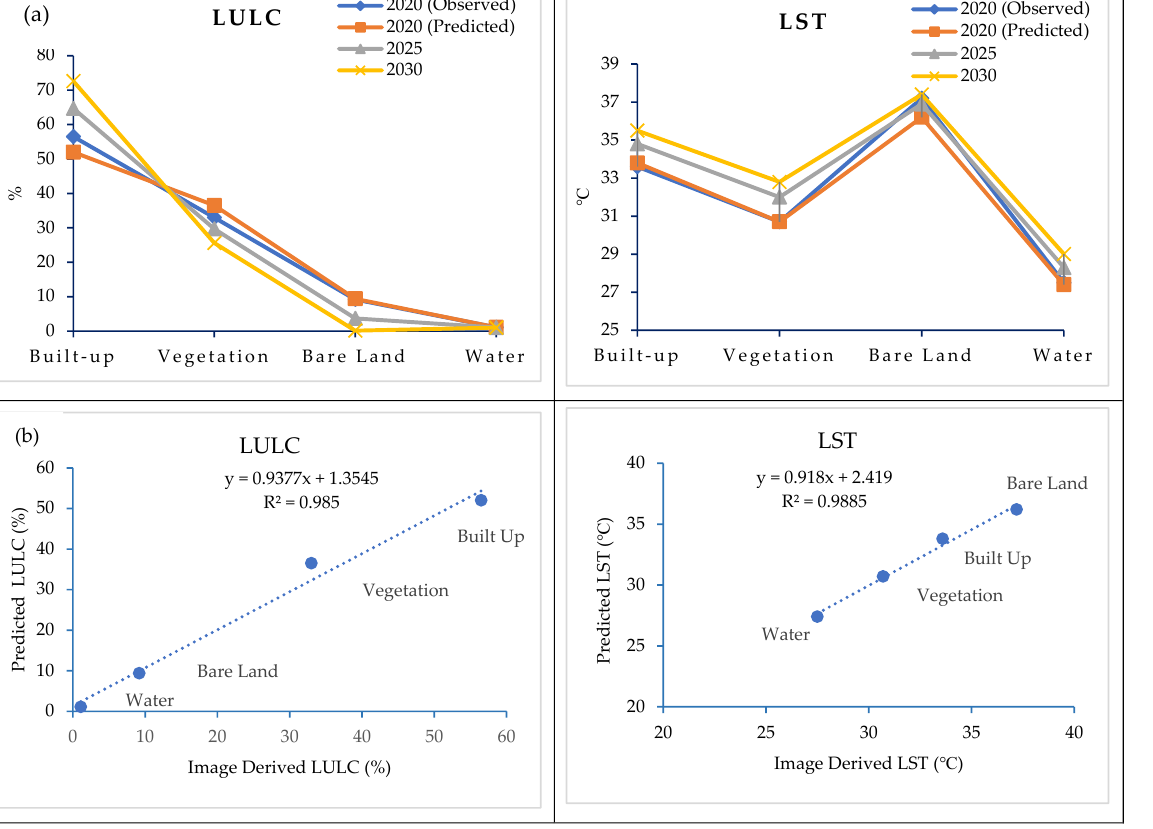
Figure 11. ( a ). LULC and LST’s validation (for year 2020) and future prediction (for year 2025 and 2030), ( b ) Comparison of predicted and image derived LULC and LST for 2020 .